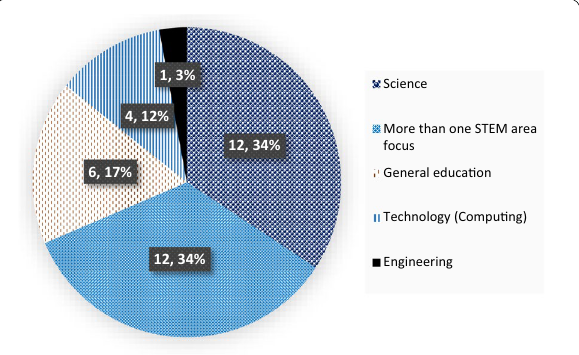
Fig. 3 Publication date of included